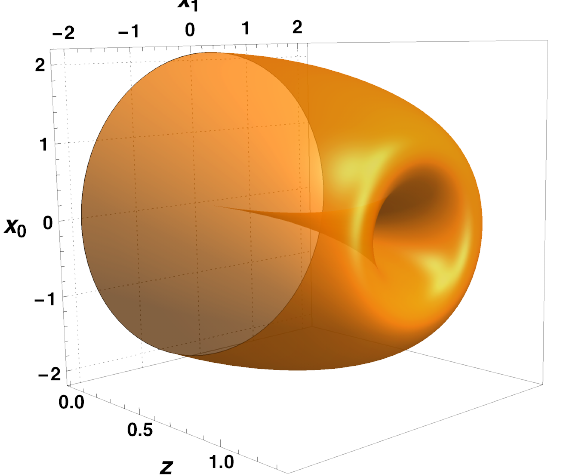
Figure 1 . A 2D contour of the 5D Lagrangian density (3.17) (multiplied by the volume factor 2 π 2 x 3 and for ρ = 1 ) evaluated at 10, depicting an instanton and anti-instanton both located at x µ = 0 (where two Euclidean coordinates x 2 , 3 are not shown). As z increases, the instanton size remains fixed while the anti-instanton size grows until it annihilates the instanton at z ∼ ρ .